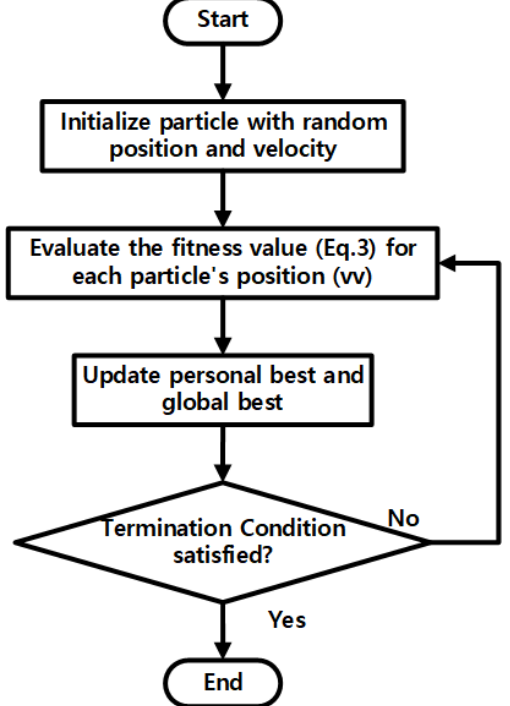
Figure 6. Flowchart for Setting Optimal Parameter of Volt–Var